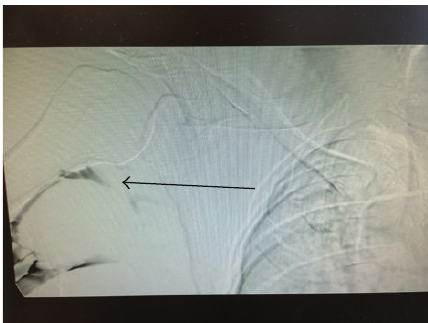
Figure 3: Chronic scarring of the right subclavian vein.